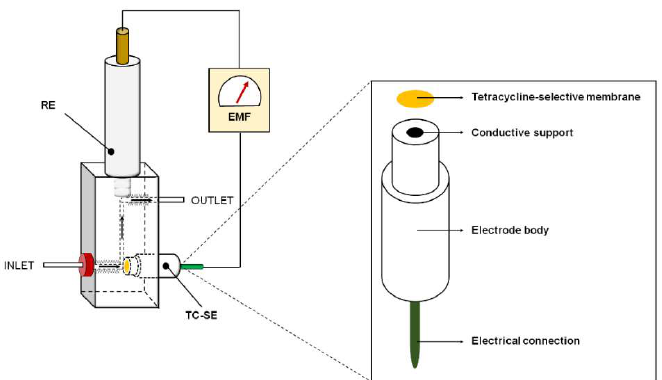
Figure 1. Illustration of the microfluidic wall-jet potentiometric cell used for the determination of tetracycline antibiotics. TC-SE—Tetracycline-selective electrode; RE—Reference electrode. Inset: Miniaturized TC-SE based on graphite conductive substrate prepared by the drop-casting of a tet- racycline-selective membrane.